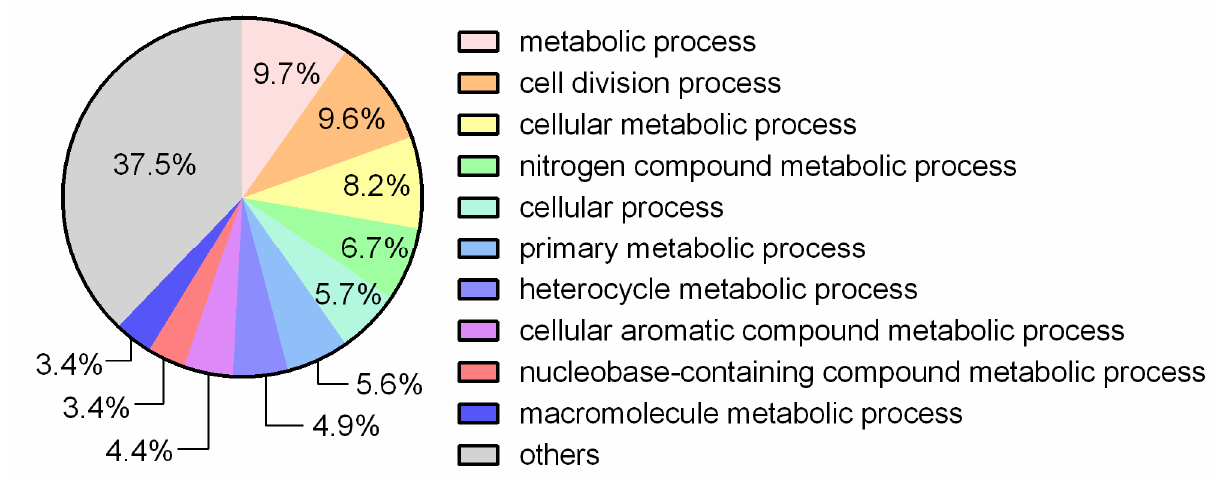
Figure 5. Molecular functions related to proteins belonging to the shared clusters by L. fermentum